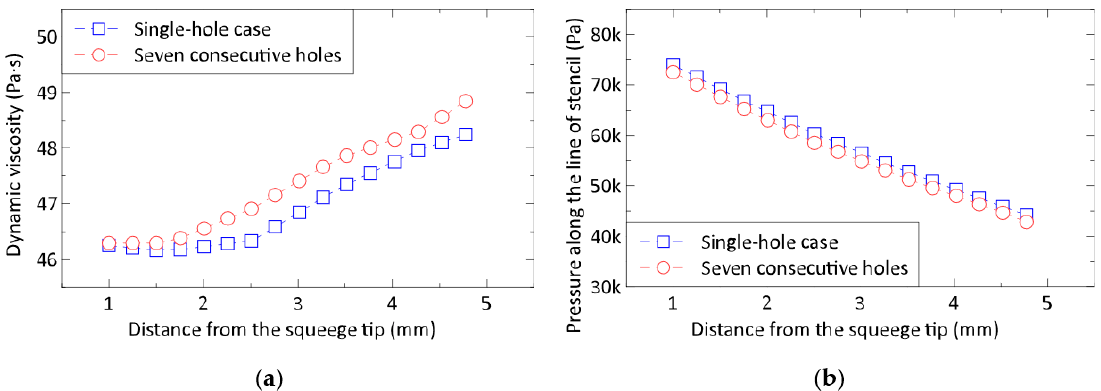
Figure 11. Comparing the cases utilizing a single hole or multiple holes in the printed wiring board (printing speed was 120 mm/s): ( a ) dynamic viscosity of the solder paste; ( b ) pressure along the line of the